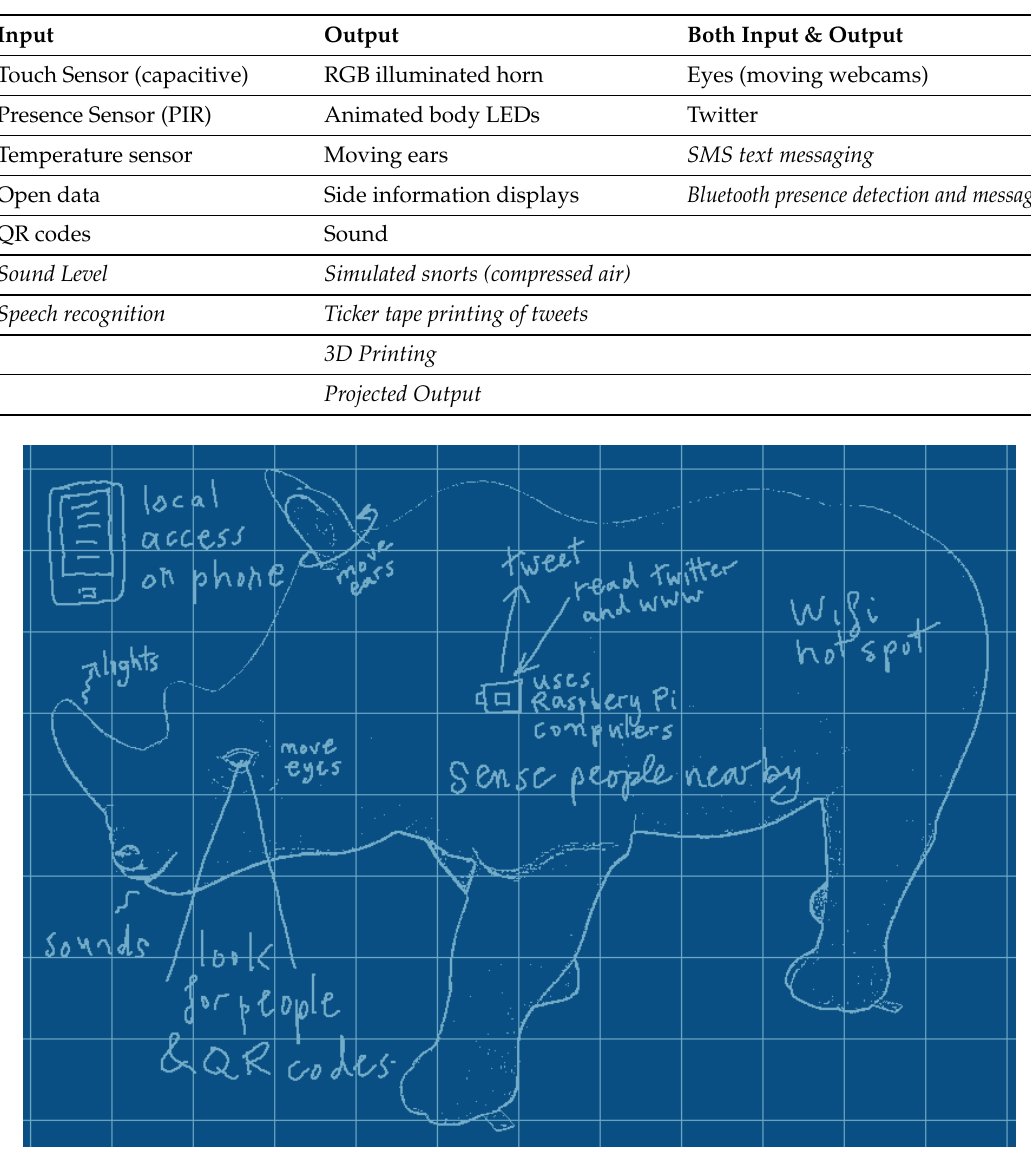
Table 1. Features that were considered for inclusion in Erica. Those in italics were considered but not implemented.